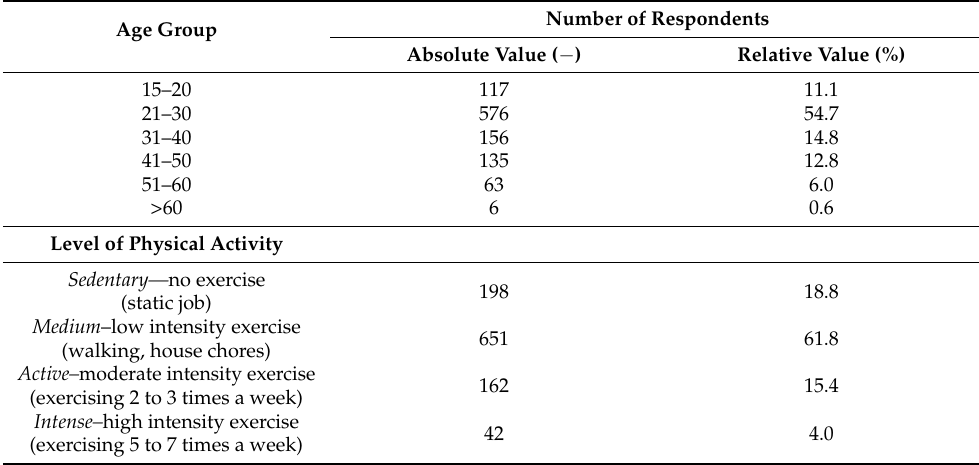
Table 1. Age and level of physical activity of the